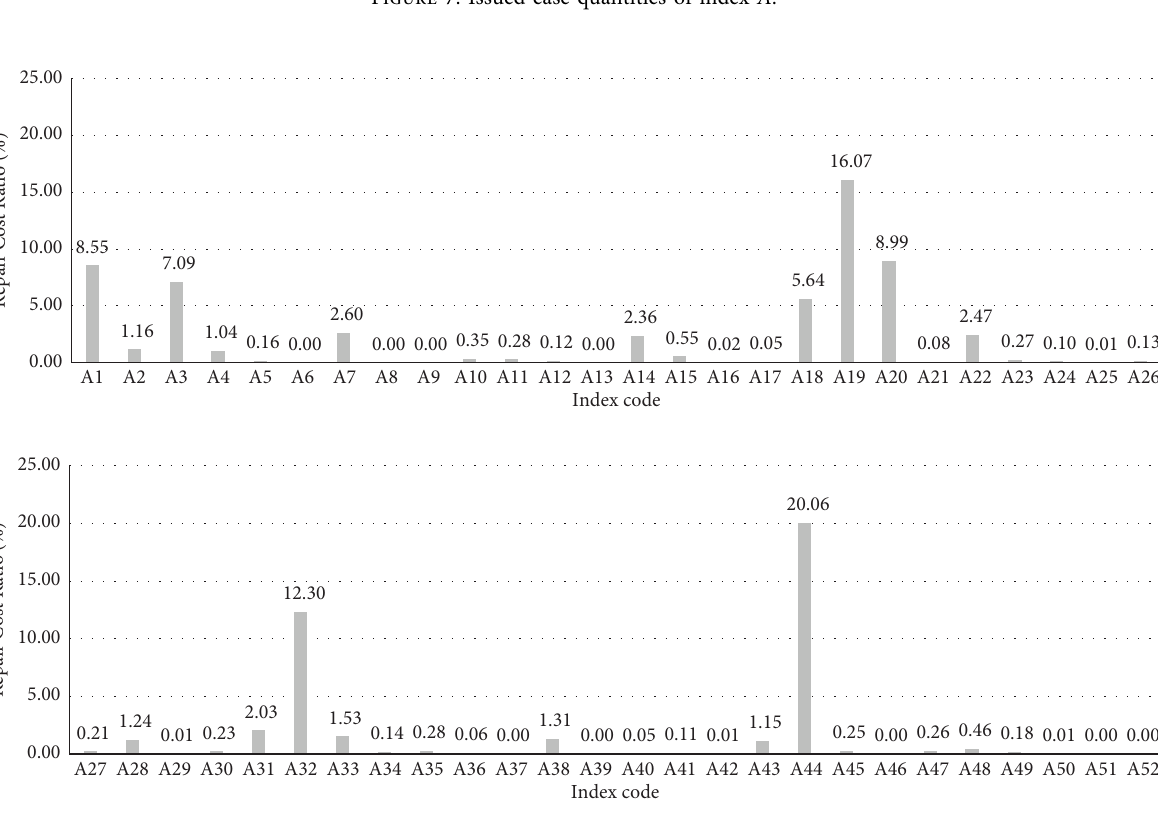
Figure 8: Repair cost ratio of index A